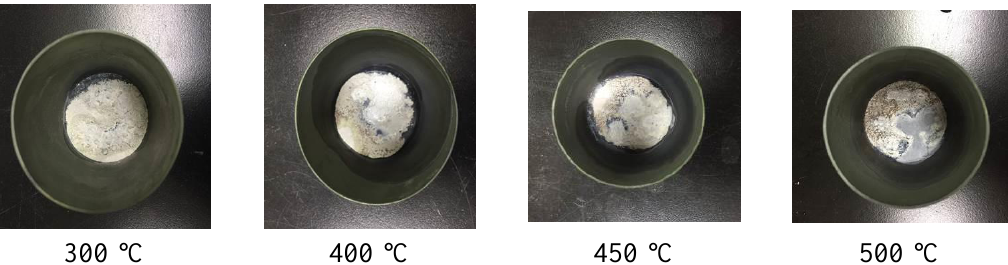
Figure 2. Photographs of the roasting products in the crucibles after roasted at various temperatures (experimental conditions: abrasive – glass polishing waste: approximately 1 g; mass ratio of polishing waste to NaOH: 1:1; roasting time: 2 h).